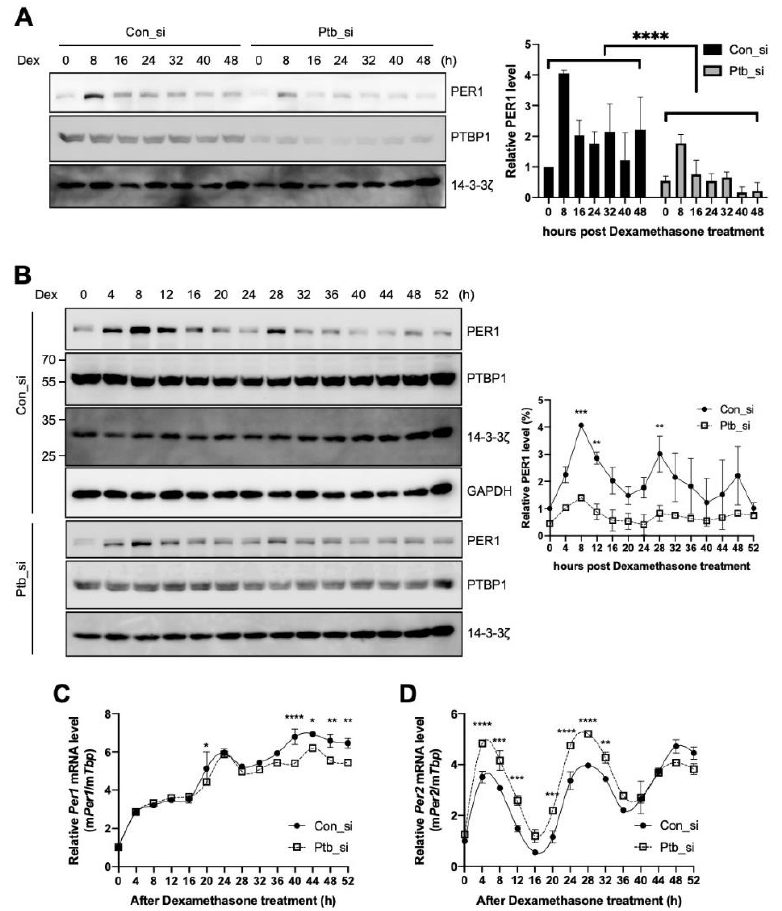
Figure 5. Polypyrimidine tract-binding protein 1 (PTBP1) regulates the circadian rhythm of the